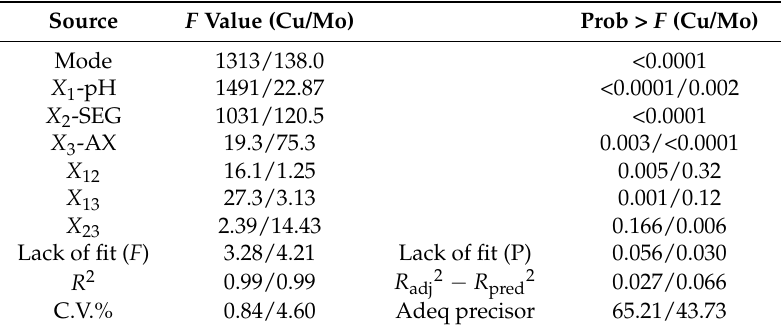
Table 3. ANOVA for response surface quadratic model